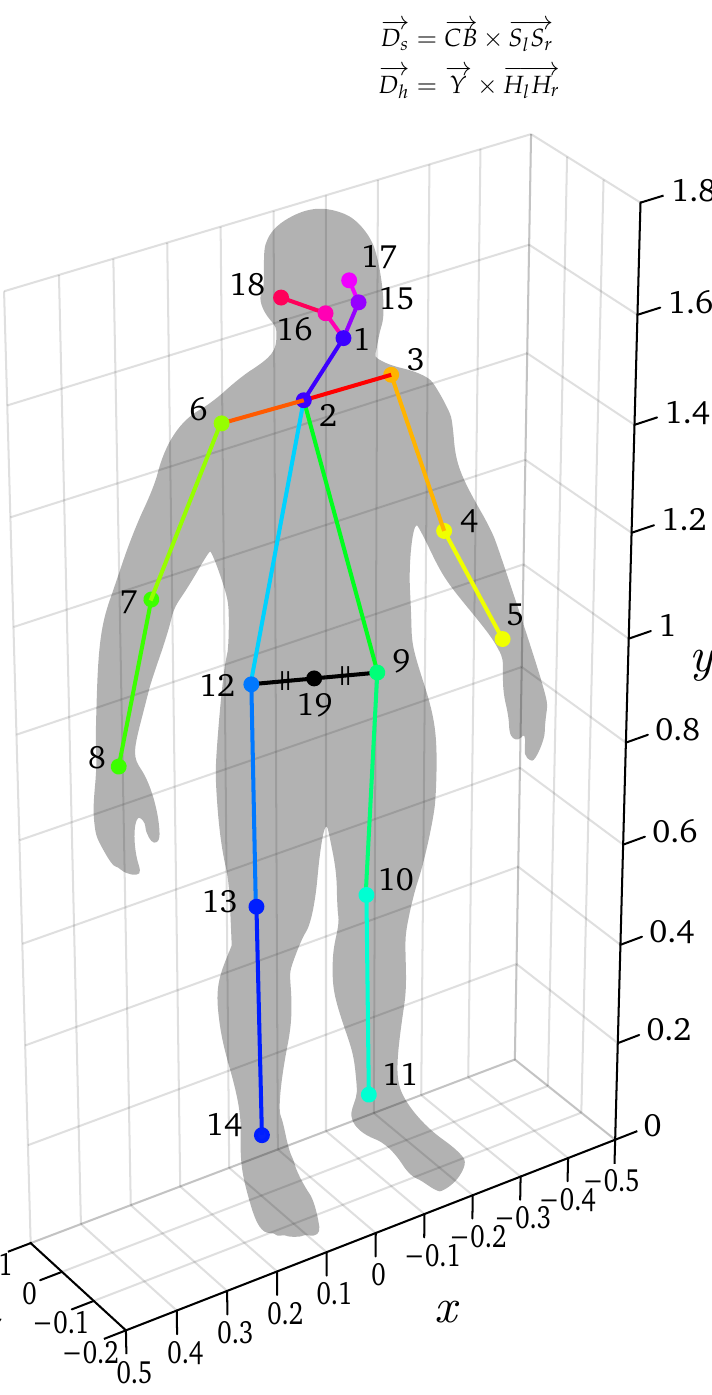
Figure A1. The used skeleton